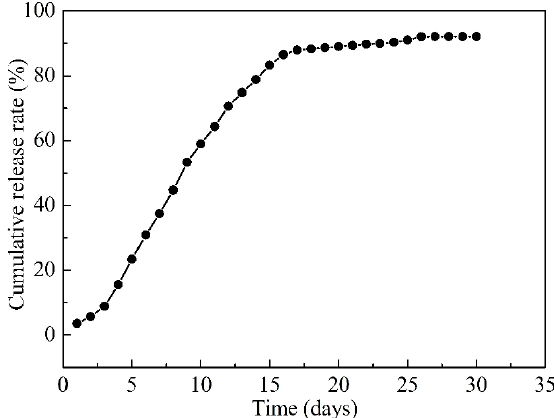
/ PLGA / BR coating in